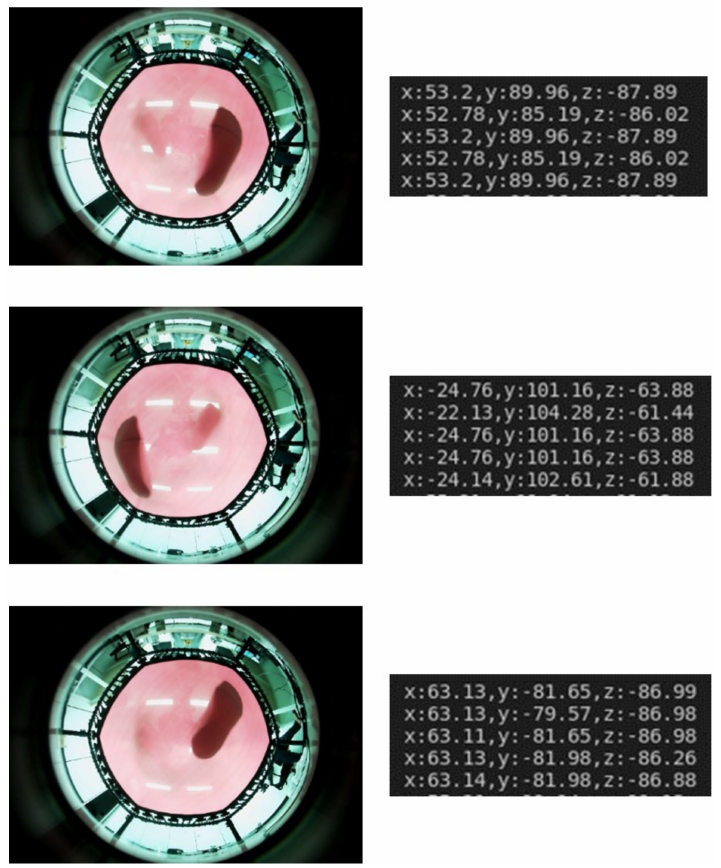
Figure 12. 3D foot position of the experimental subject estimated by the 3DFPE-DL algorithm ( left : images acquired by the camera module; right : numerical values of the 3D foot position estimated in 0.1 s